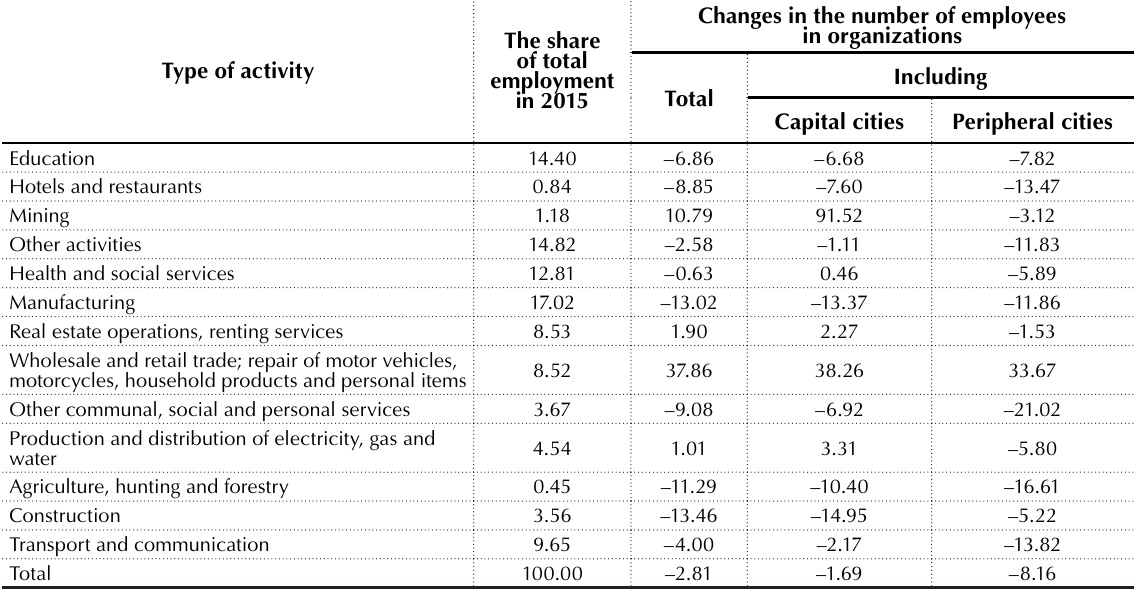
Table 8. Changes in the number of employees in organizations in cities of the Siberian Federal District, 2009–2015,